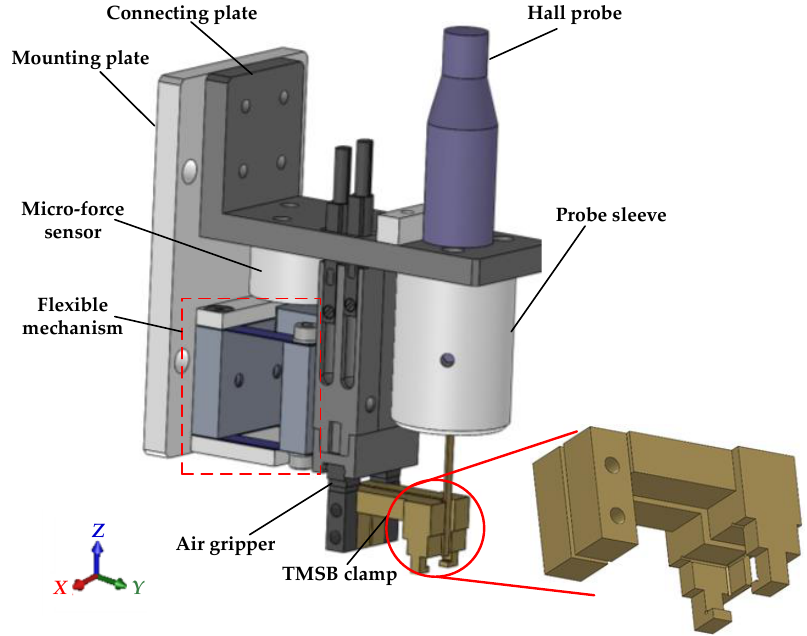
Figure 5. Schematic diagram of the TMSP matching module.